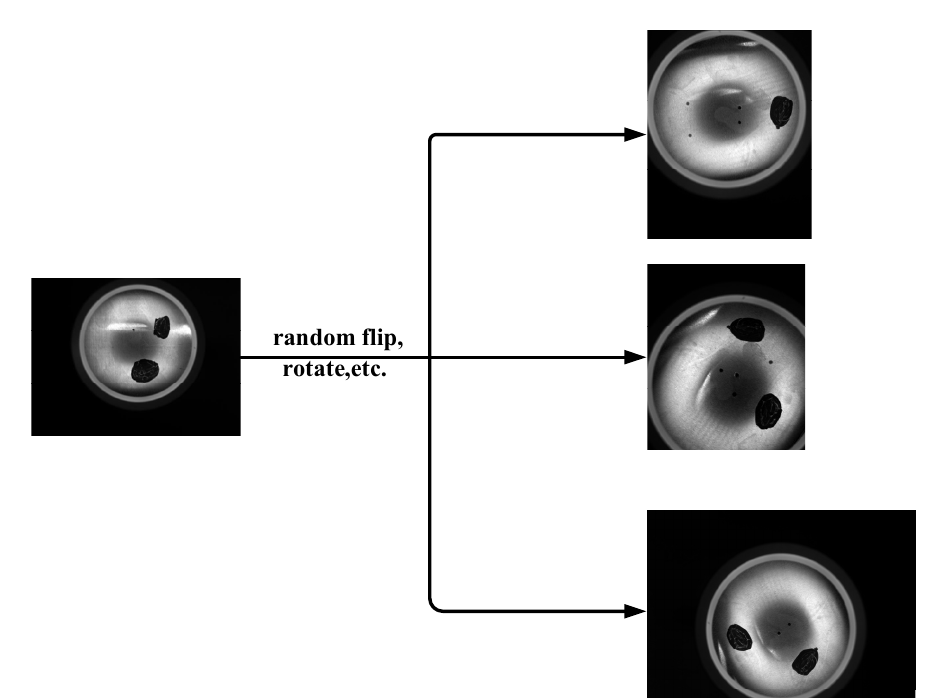
Figure 2. Images were obtained using the expansion technique.